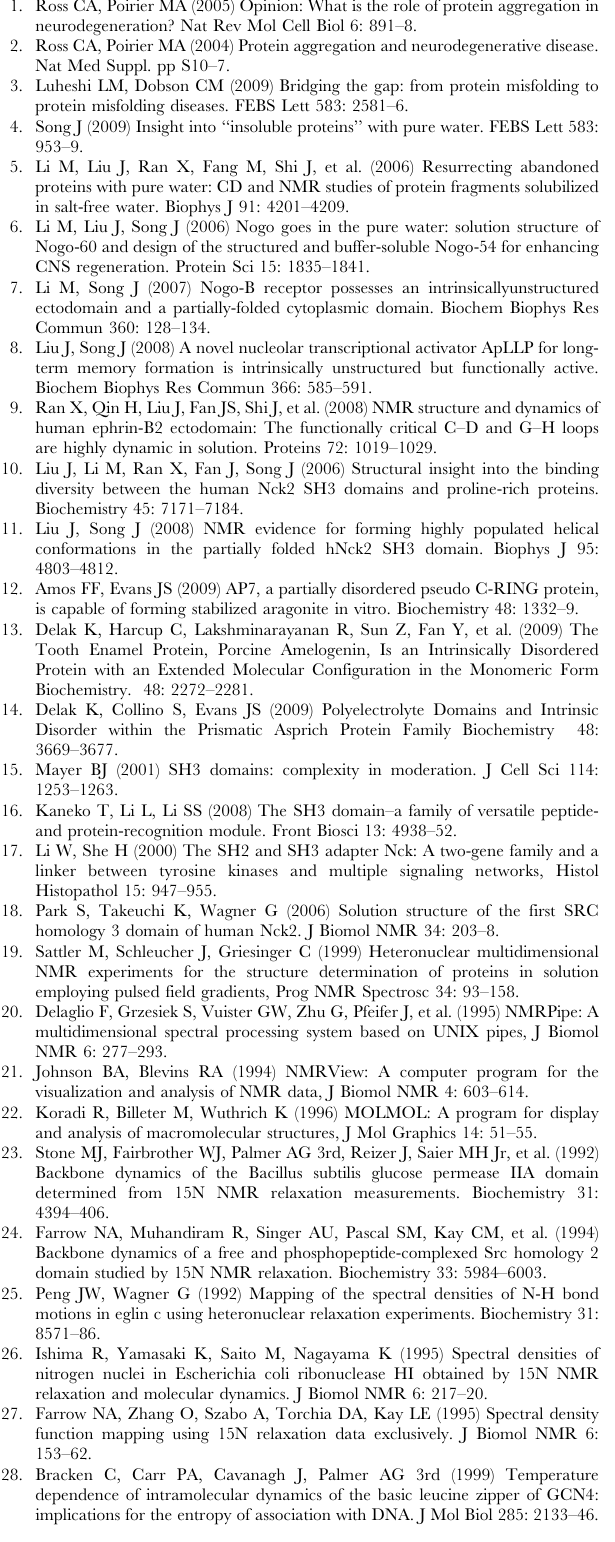
Table S2 Non-native NOEs identified in